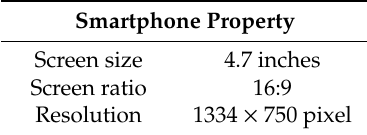
Table 1. The parameters of the smartphone (iPhone